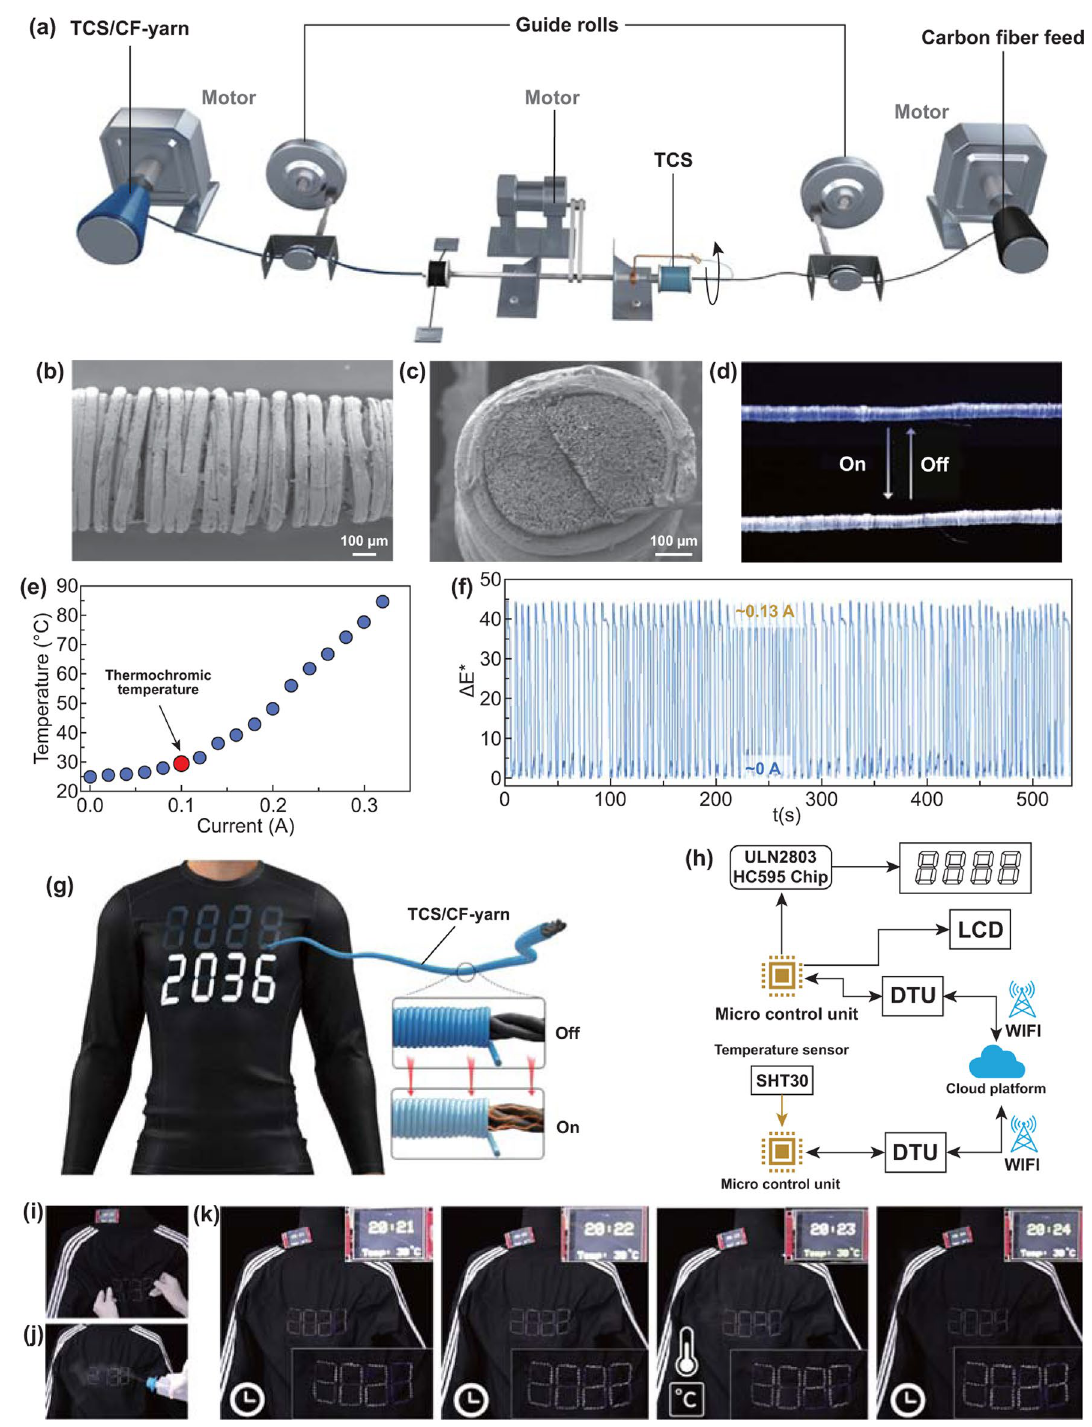
Fig. 5 Design, fabrication and performance of TCS-based dynamic textile displays. a Schematic diagram of the co-wrap spinning apparatus for fabricating TCS/ carbon fiber yarns. b , c SEM image of surface morphology ( b ) and cross section ( c ) of TCS/carbon fiber yarns. d Photograph of TCS/carbon fiber yarn showing smart color-changing effect by applying currents of 0.13/0 A. e Plot of temperature versus applied current on TCS/carbon fiber yarn, the red point refers to thermo- chromic temperature. f The stability of Euclidean distance, Δ E* , during repetitive power-on and power-off cycles by applying currents of 0.13/0 A. g Schemical illustration of a real-time digital display fabric constructed by TCS/carbon fiber yarns. h Schemical illustration of driving device for multi-module dynamic display, micro control unit (MCU) is responsible for switching time and temperature display, processing data from temperature sensor and driving the chip. The data trans- mission unit (DTU) plays a function for data transfer between MCU and cloud platform. i , j Real-time display under deformation ( i ) and rainning ( j ). k The multi- module dynamic textile display of switchable time and